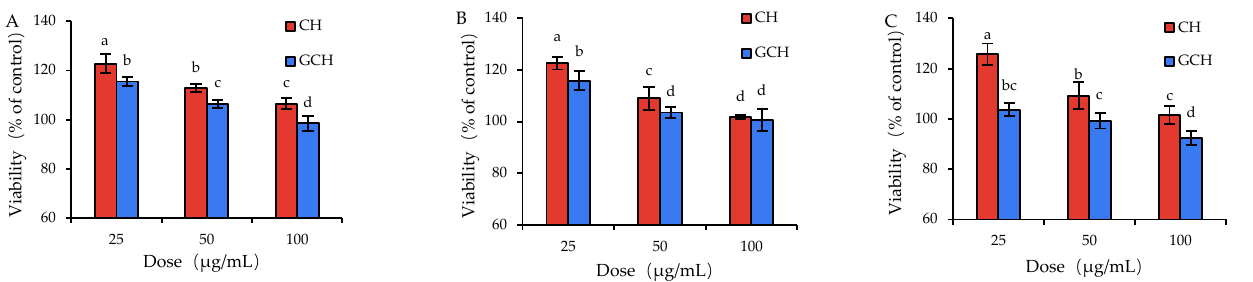
Figure 1. Viability values (%) of the IEC-6 cells treated with casein hydrolysate (CH) and glycated casein hydrolysate (GCH) for 12 h ( A ), 24 h ( B ), and 48 h ( C ), respectively. The one-way ANOVA of the mean values with different lowercase letters above the columns indicates a significant difference ( p < 0.05).